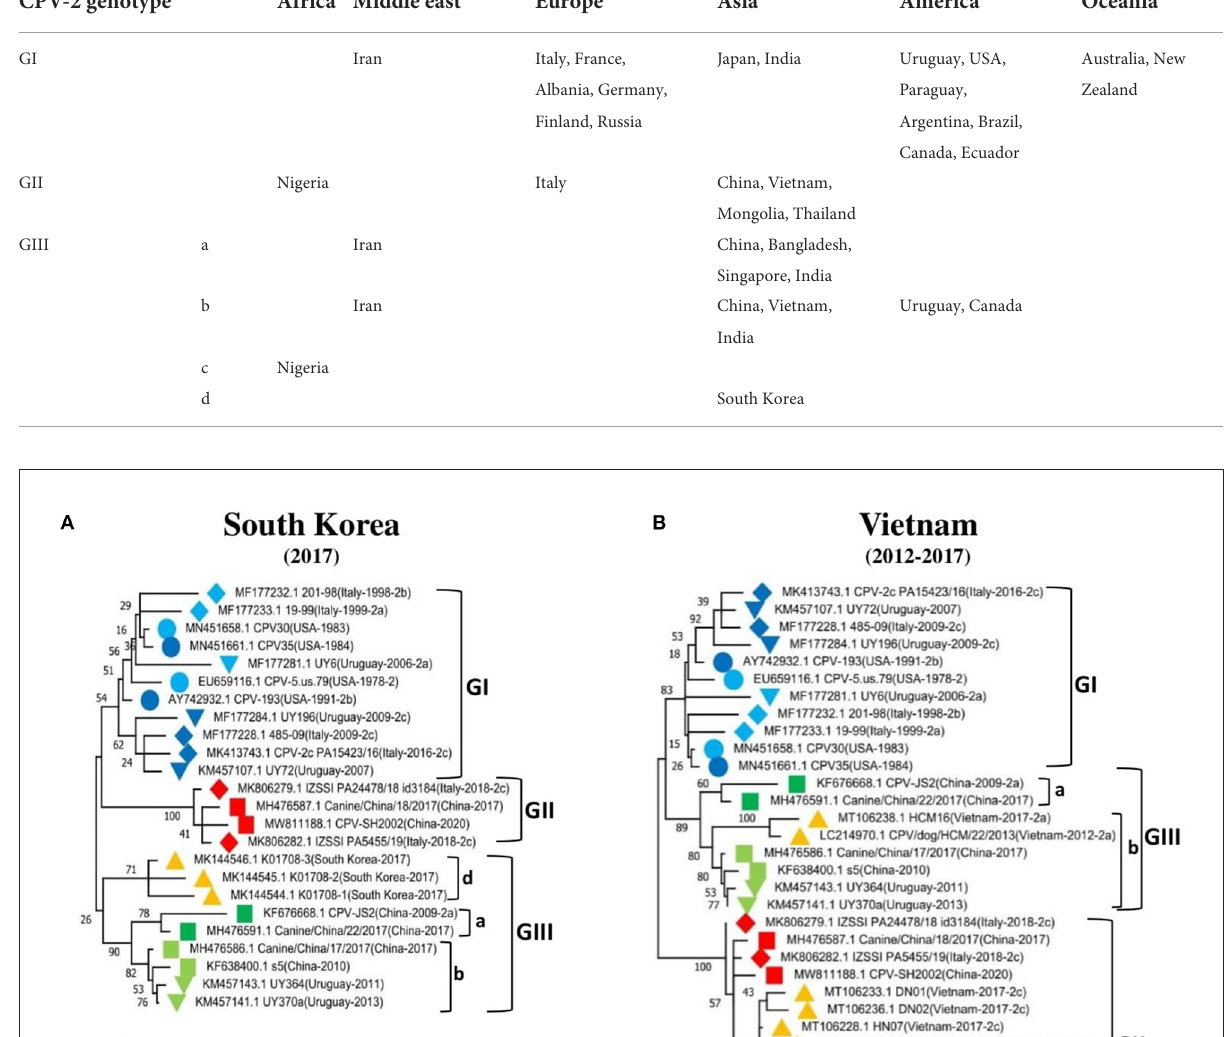
the USA, and Uruguay). The extended PI analysis of multiple viral proteins (NS1, NS2, and VP1/VP2) in our report identified distinct molecular signatures of strains from each